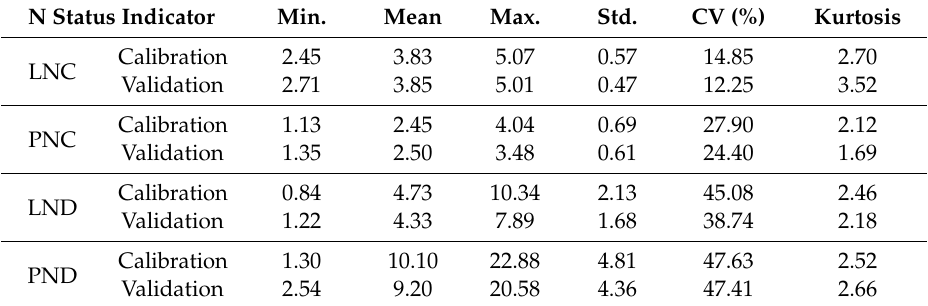
Table 3. Descriptive statistics for the winter wheat leaf N concentration (LNC) (%),plant N concentration (PNC) (%), leaf N density (LND) (g / m 2 ), and plant N density (PND) (g / m 2 ) of calibration and validation datasets.